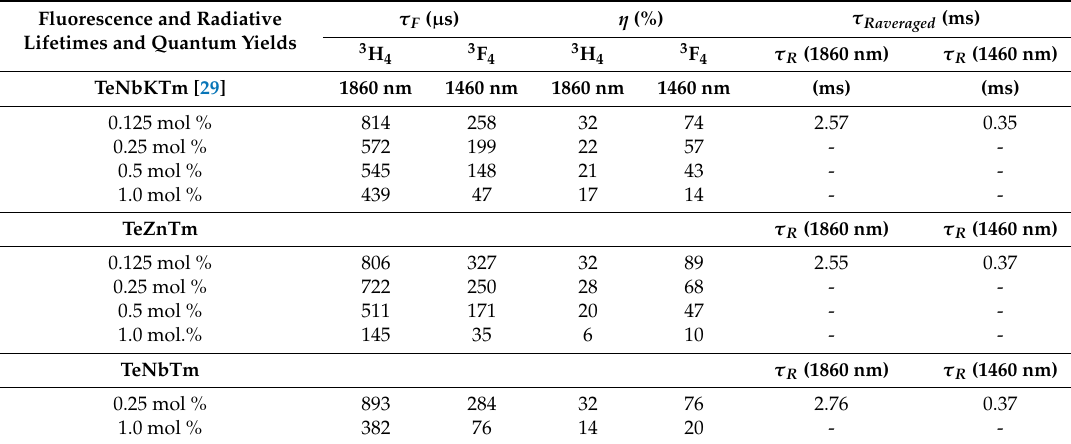
Table 2. Measured fluorescence lifetimes ( τ F ), calculated radiative lifetimes ( τ R ), and the corresponding luminescence quantum yields ( η ) for the two transitions at 1860 nm and 1460